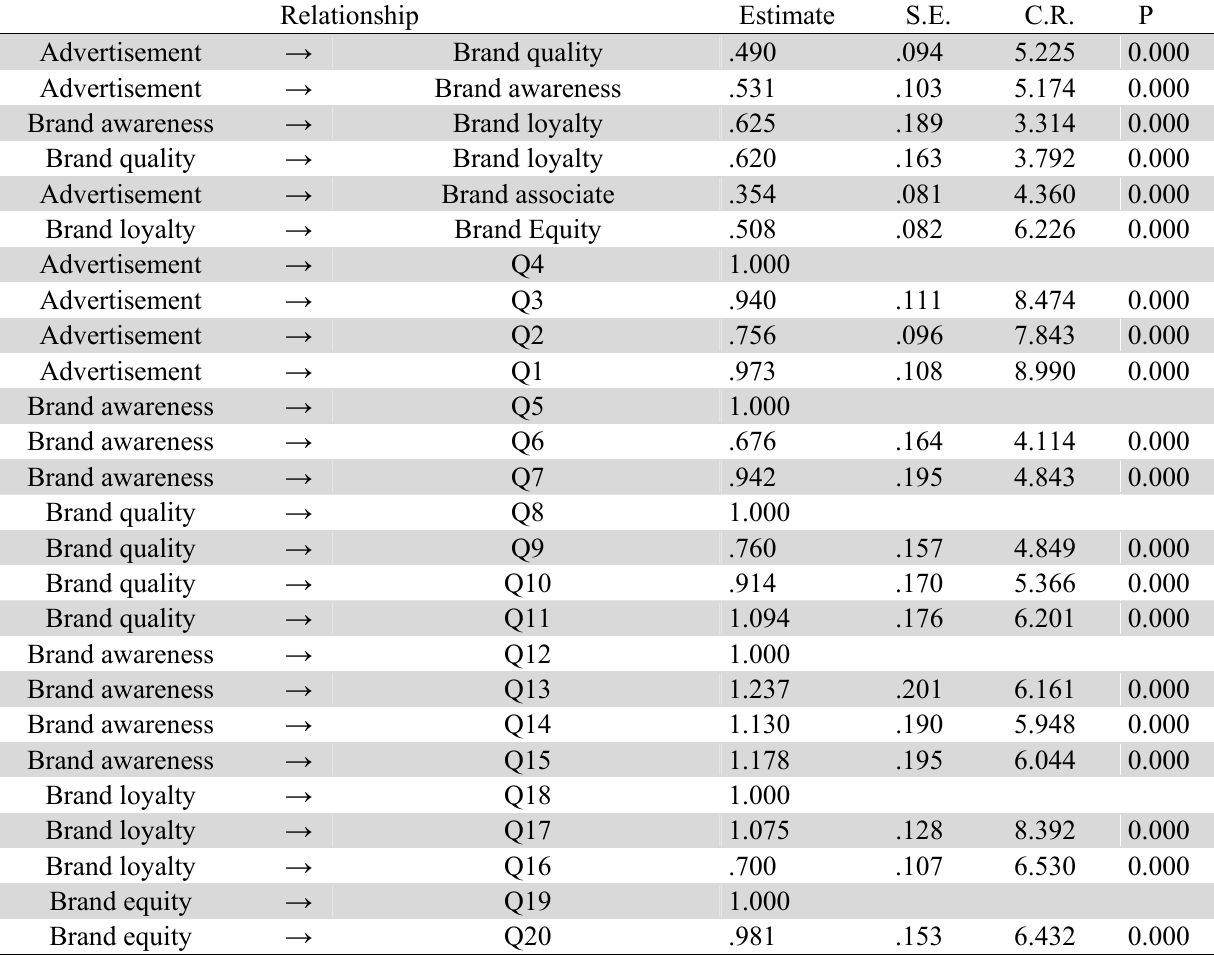
Fig. 2. The results of SEM implementation for standard coefficients (tadaei: Brand associate) The summary of the effects of various components of the survey for the second case study Relationship